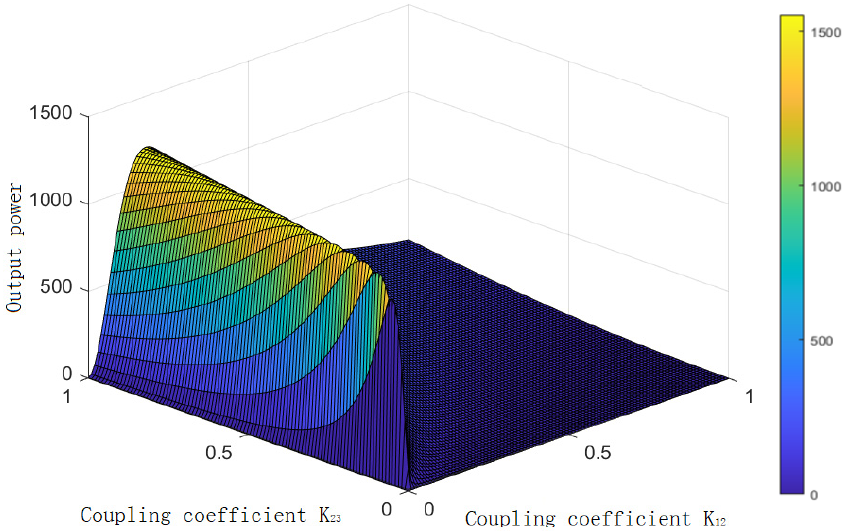
Figure 9. Relationship between output power and coupling coefficients k 12 and k 23 .